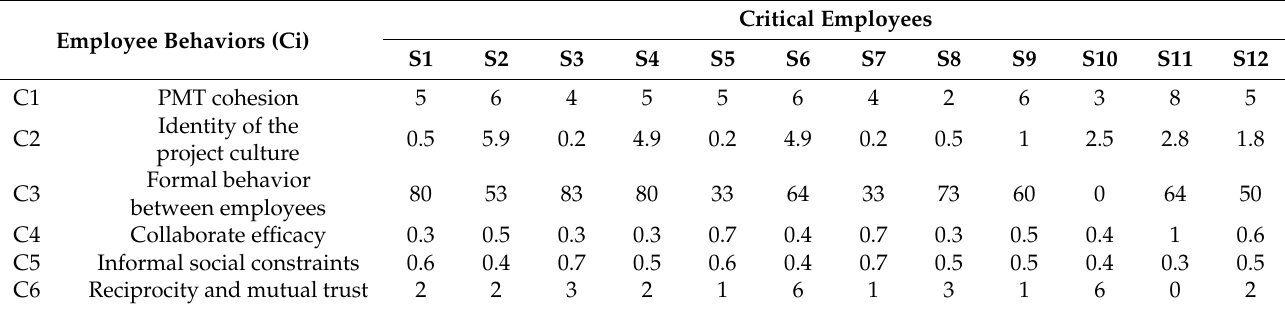
Figure 2. Social network graphs with the strength of critical employee relationships. Table 4. Employee behaviors for each critical